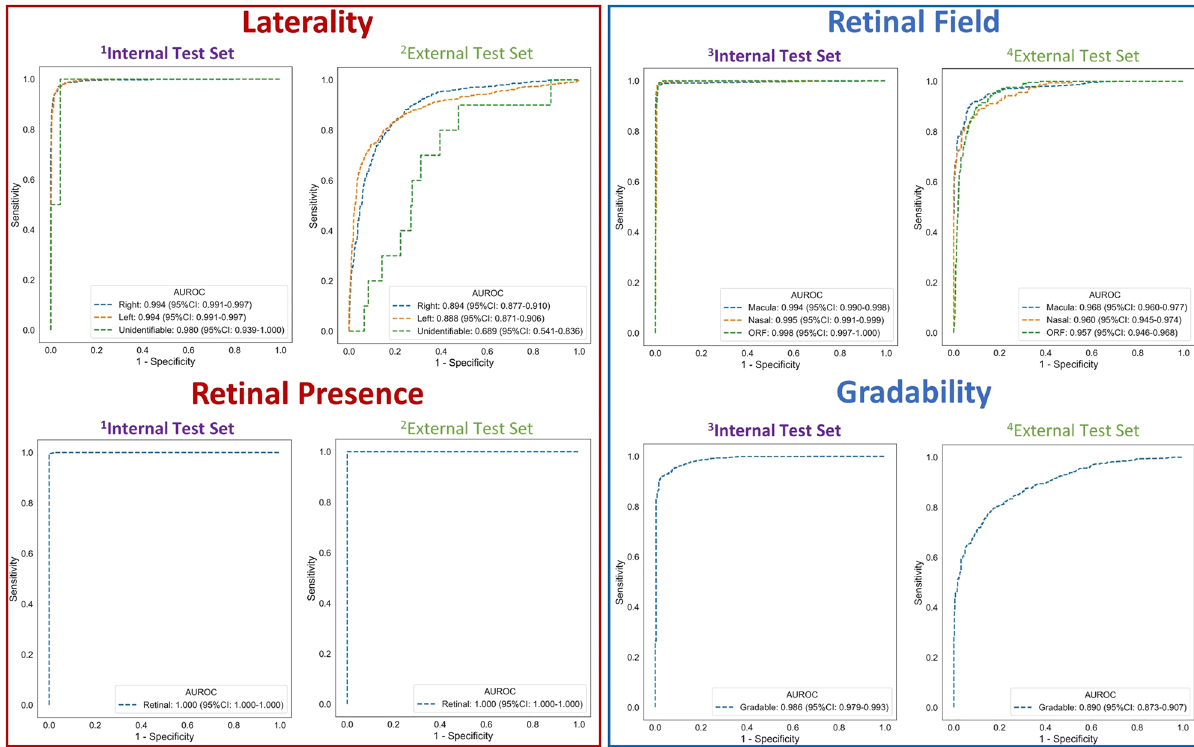
Figure 3. Single-output model receiver operating characteristic curves. 1 Test set size = 1541 images, 2 Test set size = 1479 images, 3 Test set size = 1466 images, 4 Test set size = 1427 images. AUROC: area-under-the receiver operating characteristic curve, ORF: other retinal field.